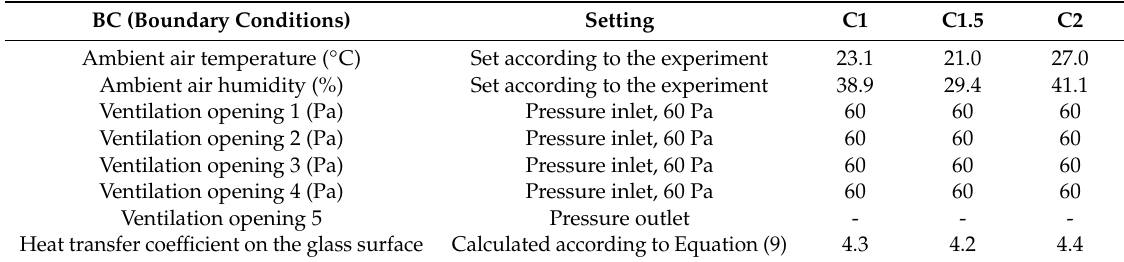
Table 5. Boundary conditions for the defogging phase simulation.